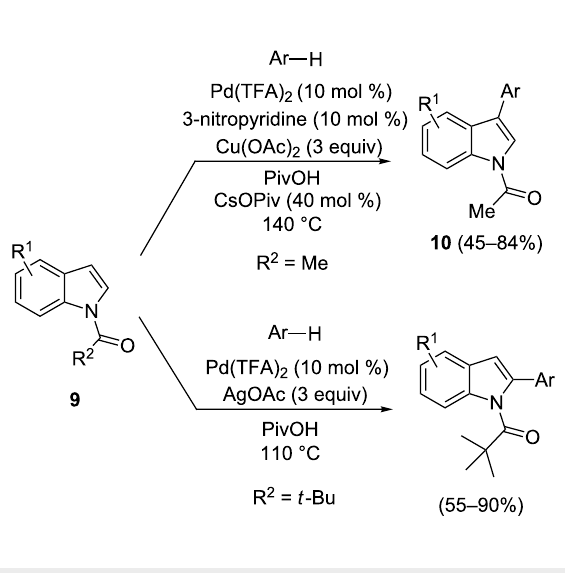
Scheme 9: Regioselective arylation of indoles by dual C–H functional- ization.